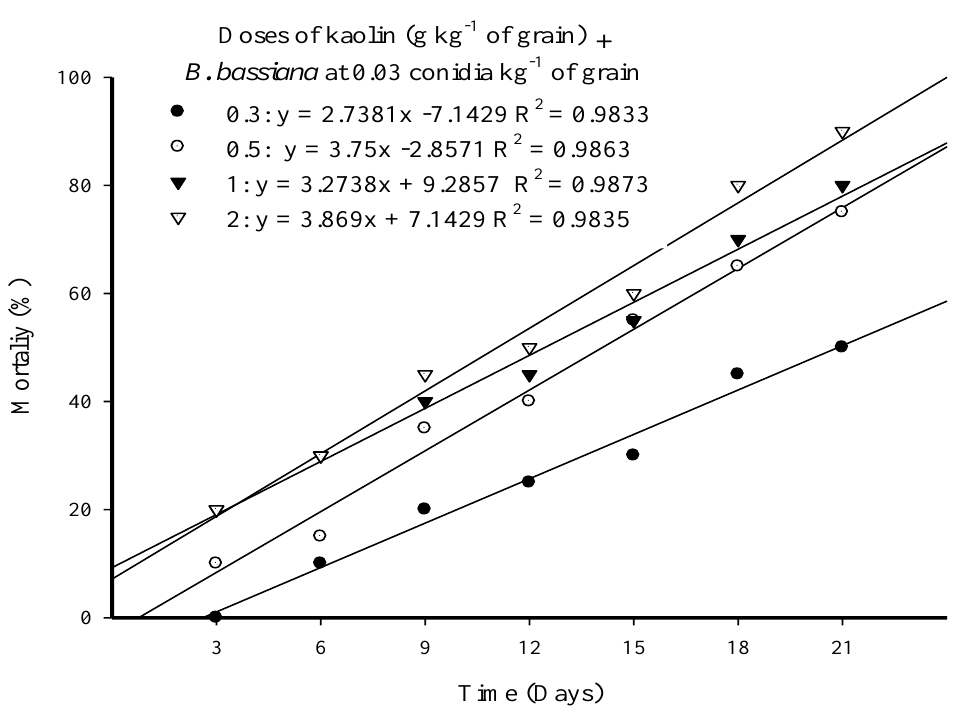
Figure 1. Corrected mortality (Abbott’s correction) of Ephestia cautella larvae following exposure to Beauveria bassiana Strain MS-8 at a fixed dose of 0.03 conidia g kg −1 formulated in kaolin at doses of 0.3, 0.5, 1, and 2 g kg −1 of grain.